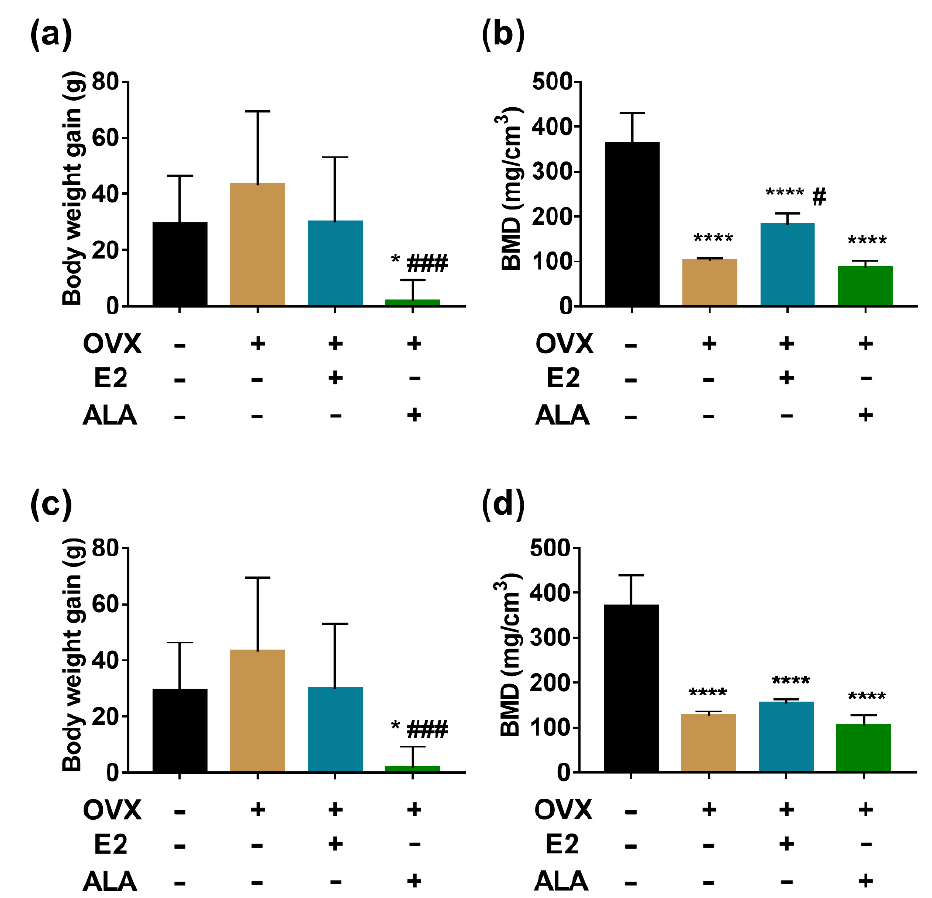
Figure 5. Effects of ALA on body weight gain and BMD in vivo. The changes in ( a ) body weight gain and ( b ) BMD of ovariectomized rat model with or without ALA preventive intervention. The changes in ( c ) body weight gain and ( d ) BMD of ovariectomized rat model with or without ALA therapeutic intervention. * p < 0.05, **** p < 0.0001 vs. the SHAM group (OVX ( − ), E2 ( − ), ALA ( − )). # p < 0.05 ### p < 0.001, vs. the OVX group (OVX (+), E2 ( − ), ALA ( − )).